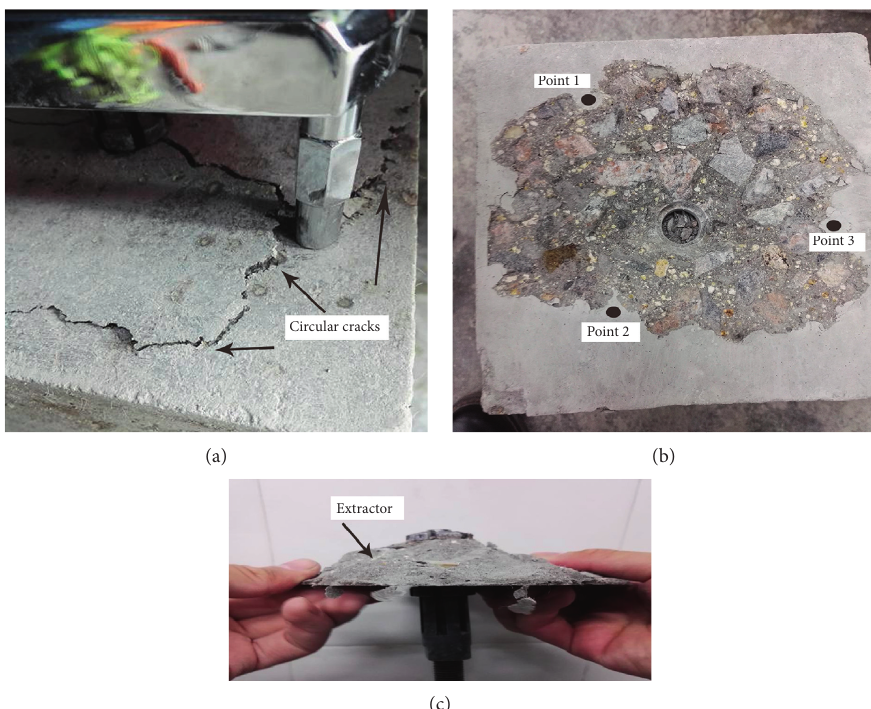
Figure 2: Photographs of the damaged specimen after postinstalled pull-out tests. (a) Circular crack on the surface of the PFRC. (b) Test specimen after the pull-out test. (c) The